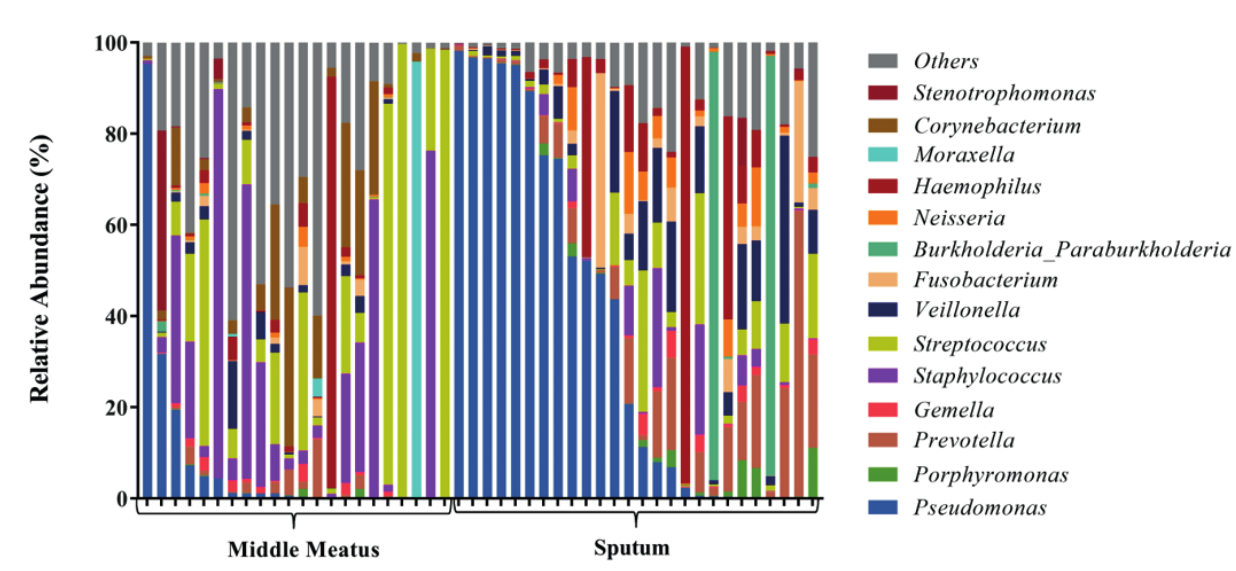
Figure 1. Relative abundance of main bacterial genera found in each patient, divided by sample site, showing differences in bacterial predominance. In the middle meatus samples, there is a higher prevalence of Streptococcus and Staphylococcus . In the sputum samples, there is a higher prevalence of Pseudomonas and Prevotella